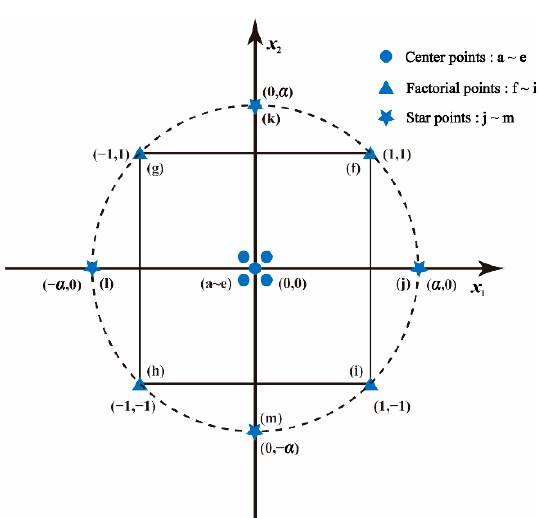
Figure 14. Test point distribution of two-factor CCD.